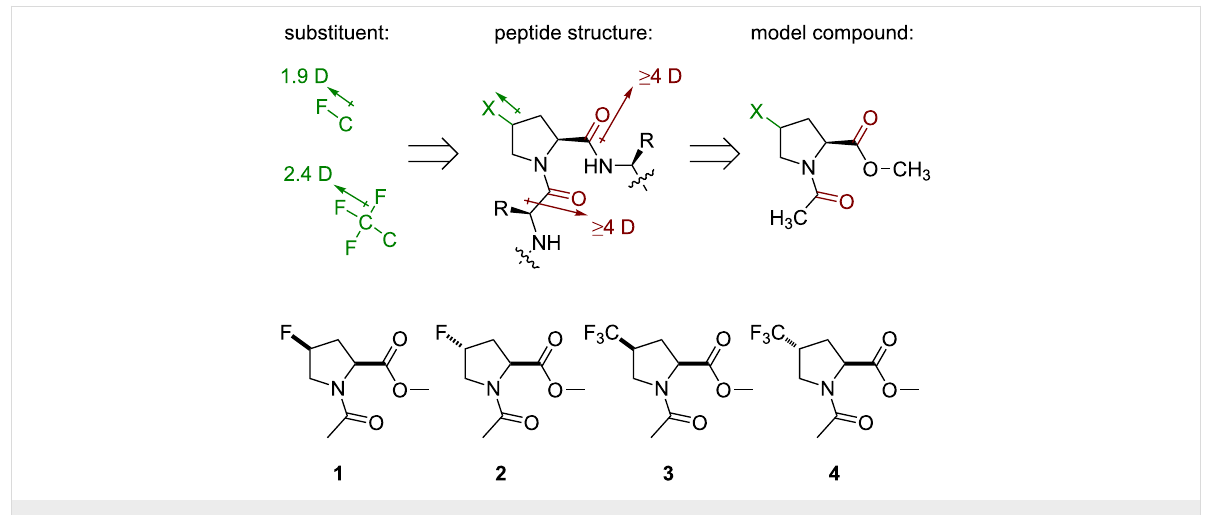
Figure 3: Design of the model